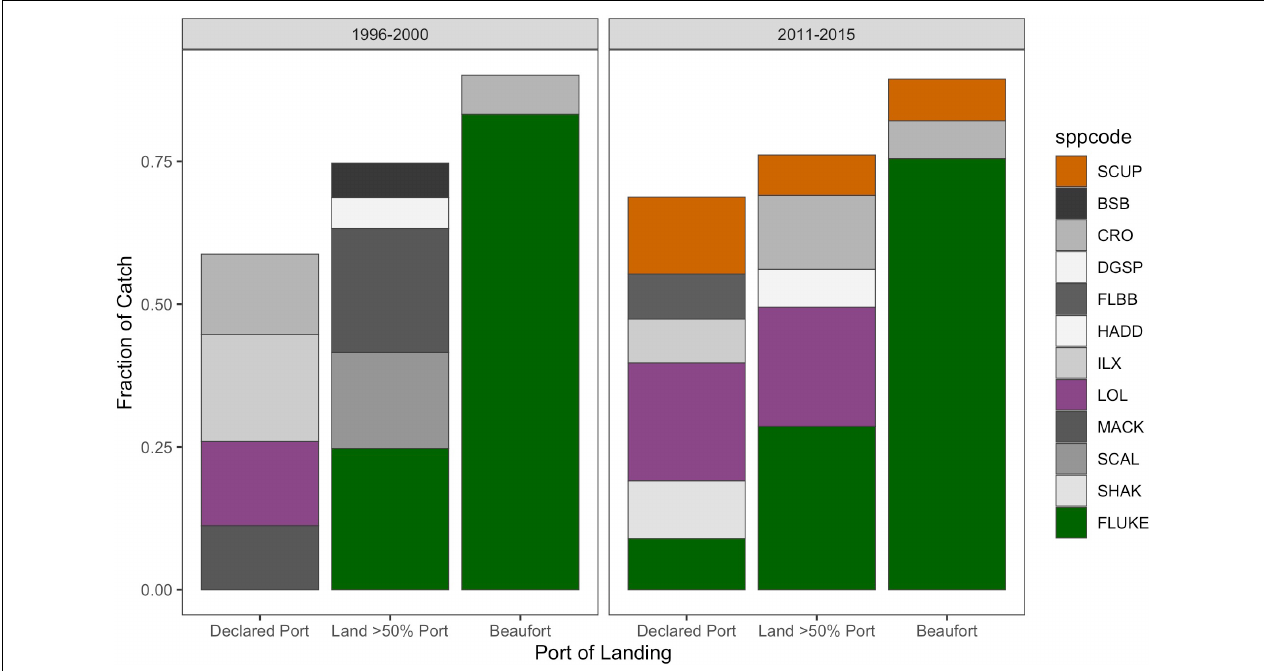
FIGURE 14 | Catch composition of transient vessels landing in Beaufort (“Beaufort”; Right-hand column) compared to when they land in one of their ports of significant association: where they have declared as their home port (“Declared port,” Left-hand column), or where they land at least 50% of their trips (“Land > 50% Port”; Middle column). Catch composition in the baseline (1996–2000) and recent (2011–2015) period. Species included comprised at least 5% of the catch in each category of association. Species codes: SCUP = scup = Stenotomus chrysops , BSB = black sea bass = Centropristis striata , CRO = Atlantic croaker = Micropogonias undulatus , DGSP = spiny dogfish = Squalus acanthias , FLBB = winter flounder = Pseudopleuronectes americanus , HADD = haddock = Melanogrammus aeglefinus , ILX = northern shortfin squid = Illex illecebrosus , LOL = longfin squid = Loligo pealeii , MACK = Atlantic mackerel = Scomber scombrus , SCAL = scallop = Placopecten magellanicus , SHAK = silver hake = Merluccius bilinearis , and FLUKE = fluke = Paralichthys dentatus